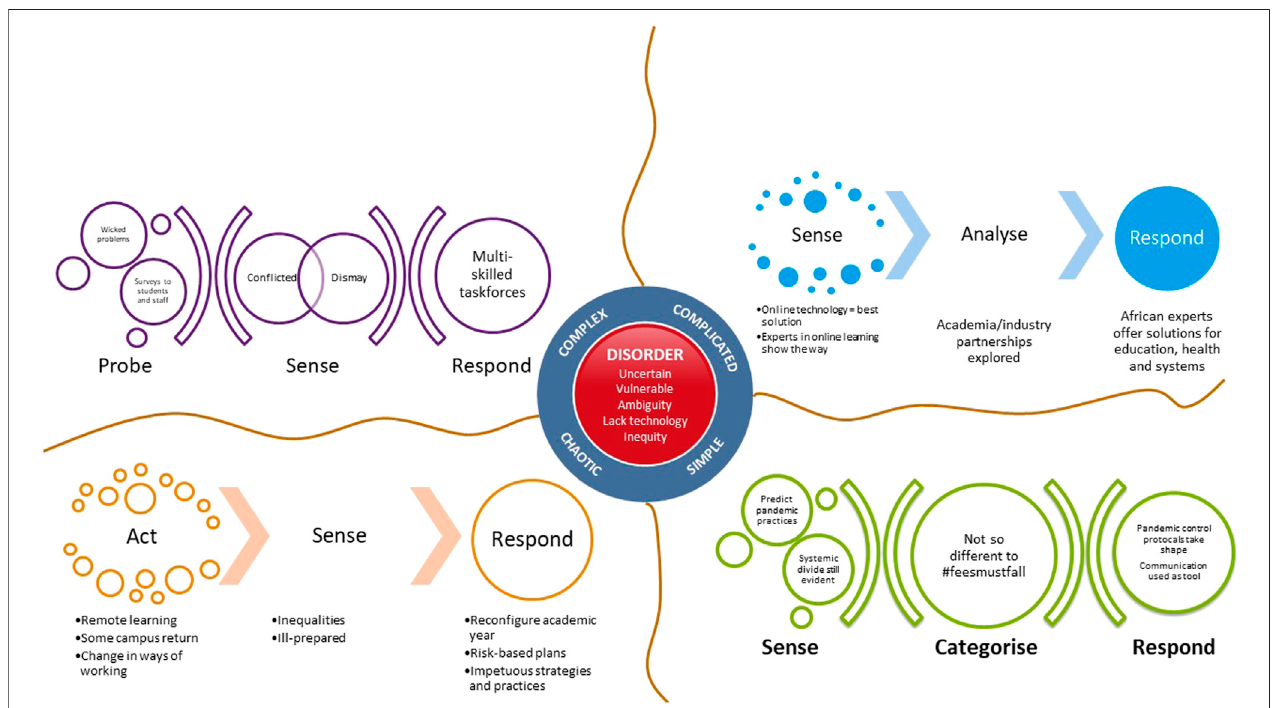
FIGURE 1 | Depiction of the study fi ndings on the Cyne fi n